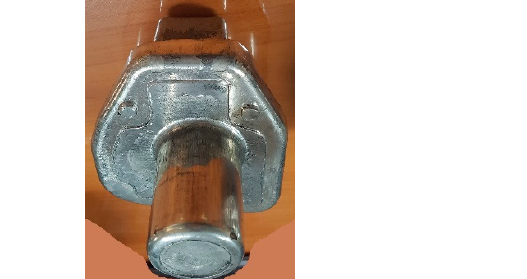
Figure 15. Experiment result of hot extrusion (produced blocker).